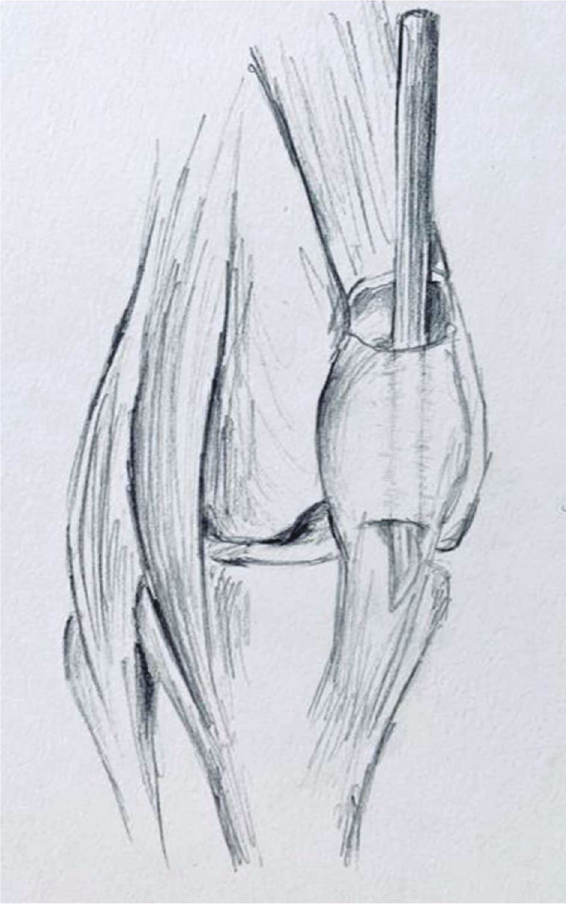
Figure 3: Illustration of preparation of subperiosteal patellar